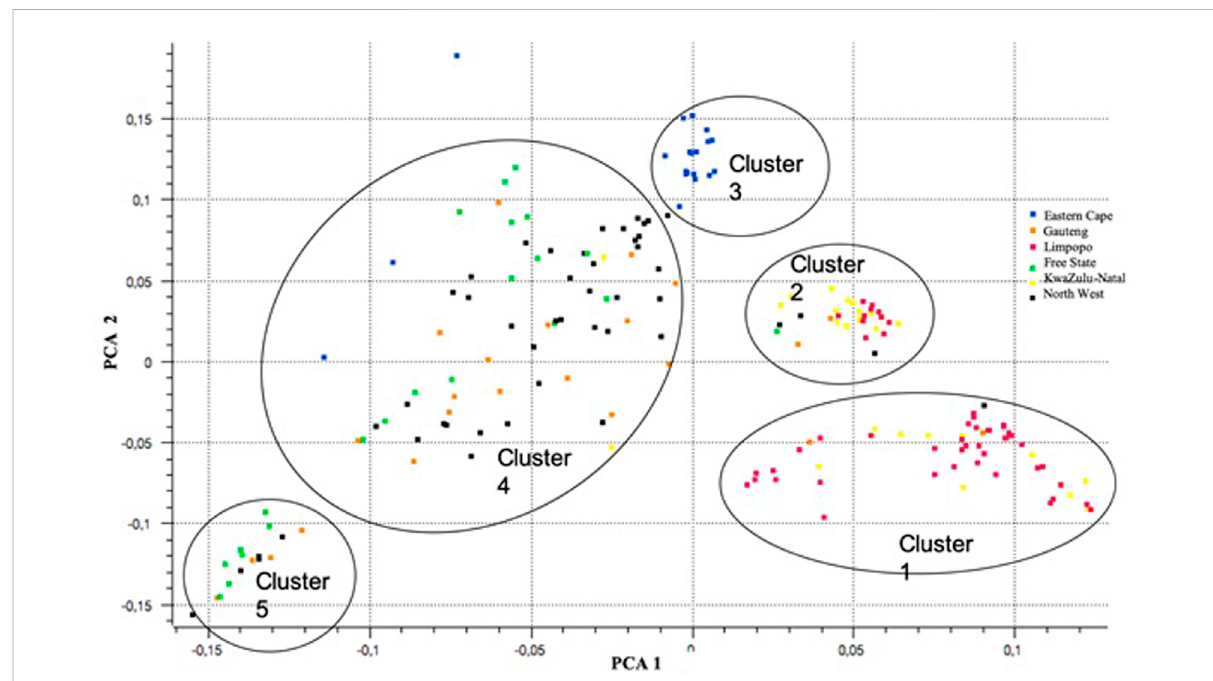
FIGURE 8 A plot of principal components (PCA) analysisshowing differentiations among theclusters of admixtures across six communal indigenous goat populations.